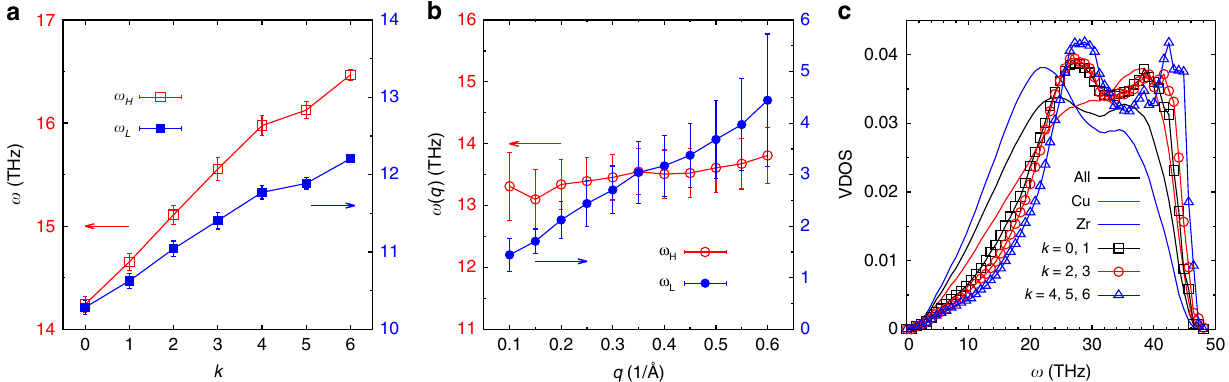
Fig. 2 The dependence of the vibrational features on connectivity k . a The frequency of the high- and low-frequency modes, ω H and ω L , increases with increasing k . q = 2.8 Å − 1 . b The frequency ω H , averaged over all k values, is basically independent of the wave-vector q showing that this is an optical mode, whereas the low-frequency mode at ω L ( q ) increases linearly with q , characteristic of an acoustic mode. Error bars in a , b have been obtained from the fi t of the SISF with Eq. (2). c Vibrational density of states for the different populations showing that the highly connected icosahedra have on average